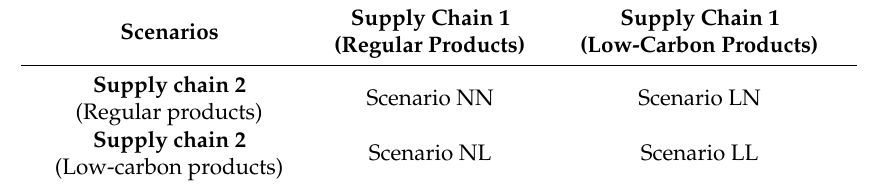
Table 2. Strategy selection game matrix of the two supply